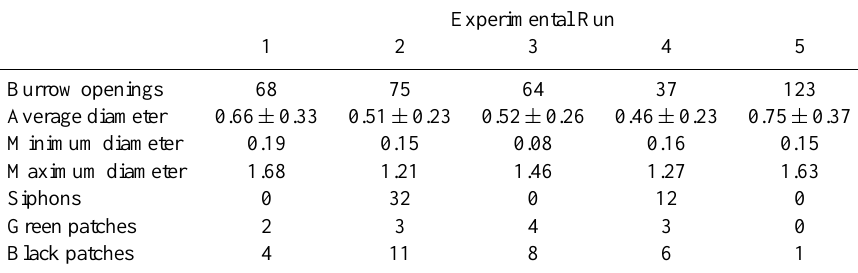
Table 2. Number and diameter (mean ± 1SD,mm) of burrow openings, number of siphons and green and black patches showing at the surface of a TS deposit overlying intertidal sediment (CTS) 4h after application of the deposit. Experimental Run